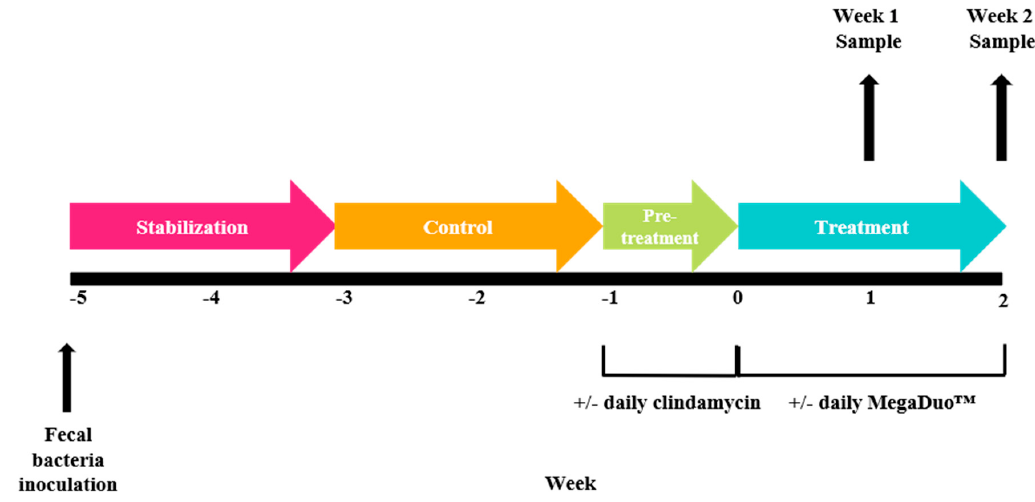
Figure 1. Schematic of the experimental design.